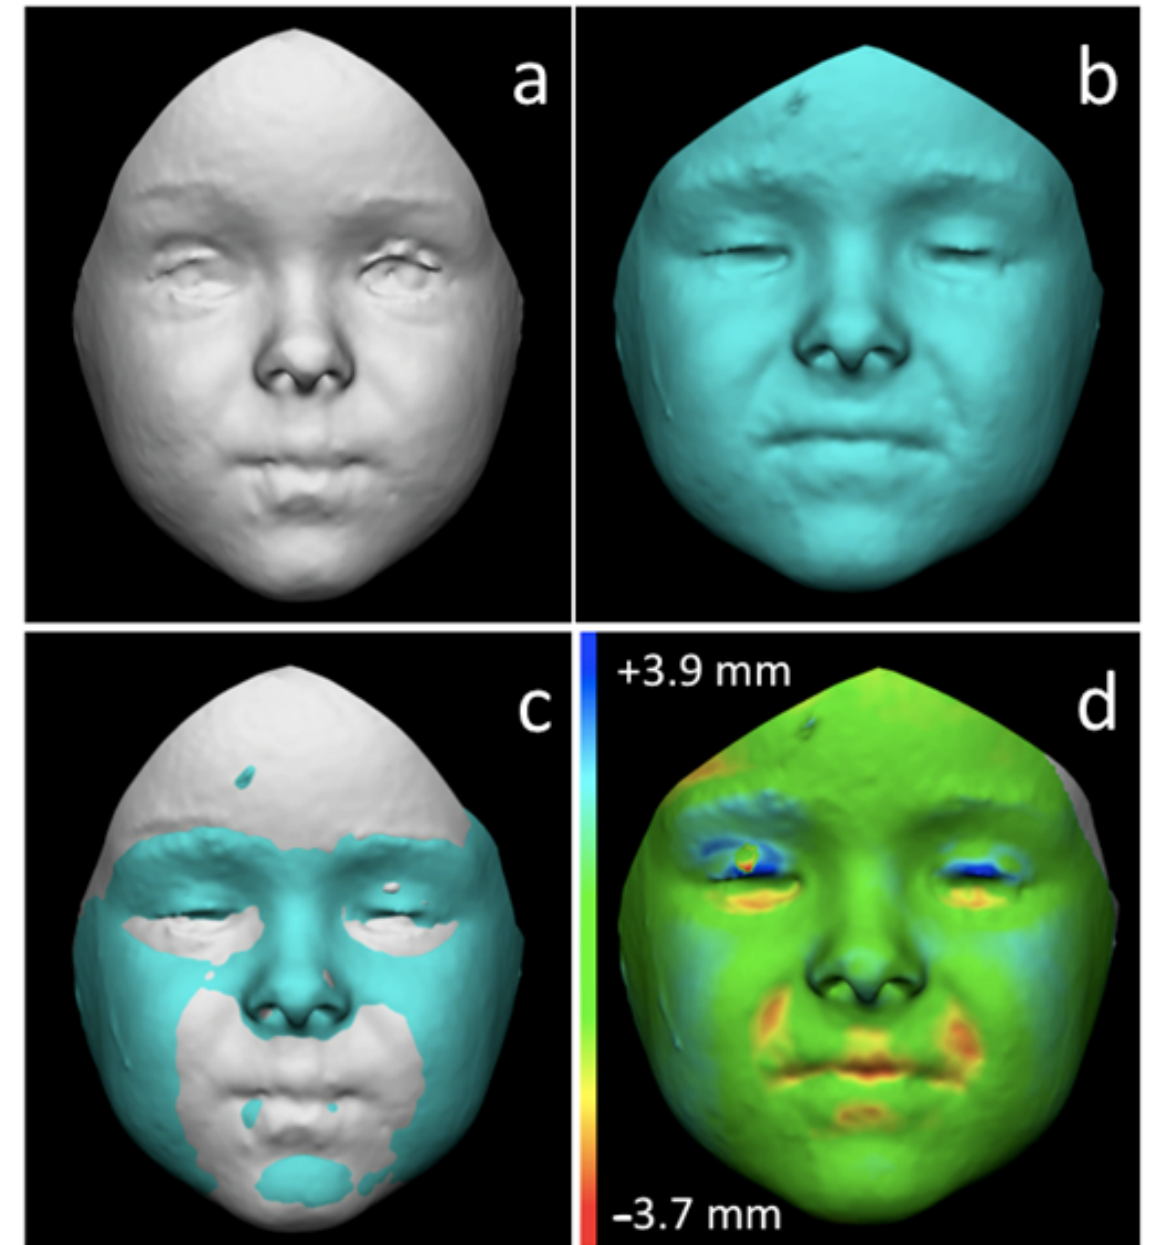
Figure 2. Steps of 3D-3D registration of two FAIs belonging to the twin sisters at T6: ( a ) FAI of the first-born twin; ( b ) FAI from the second-born twin; ( c ) registration of the two surfaces according to the least point-to-point distance between the two FAIs; ( d ) calculation of RMS (root mean square) point-to-point distance between the two models, using the first born twin as reference: blue areas are protruding in the second-born twin according to the first-born one; red areas are recessing in the second-born twin according to the first-born one; green areas are concordant in both the twins. Values of RMS distances acquired from the twin sisters at the different time periods were then compared with reference values of facial similarity of monozygotic adult twins.